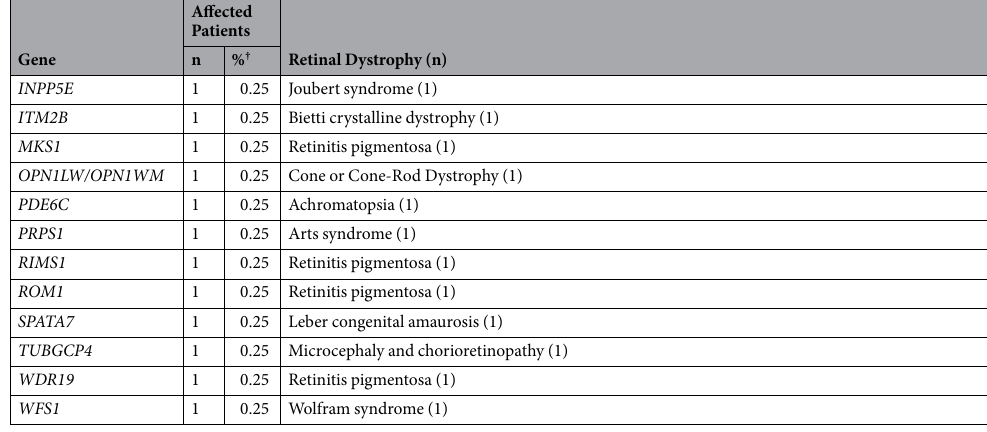
Table 3. Number of affected patients with positive genetic testing per gene. Total of disease-causing genes is 66. * PHARC: Polyneuropathy, Hearing loss, Ataxia, Retinitis pigmentosa and Cataract. † Percentage based on the total number of patients with positive genetic test (n =